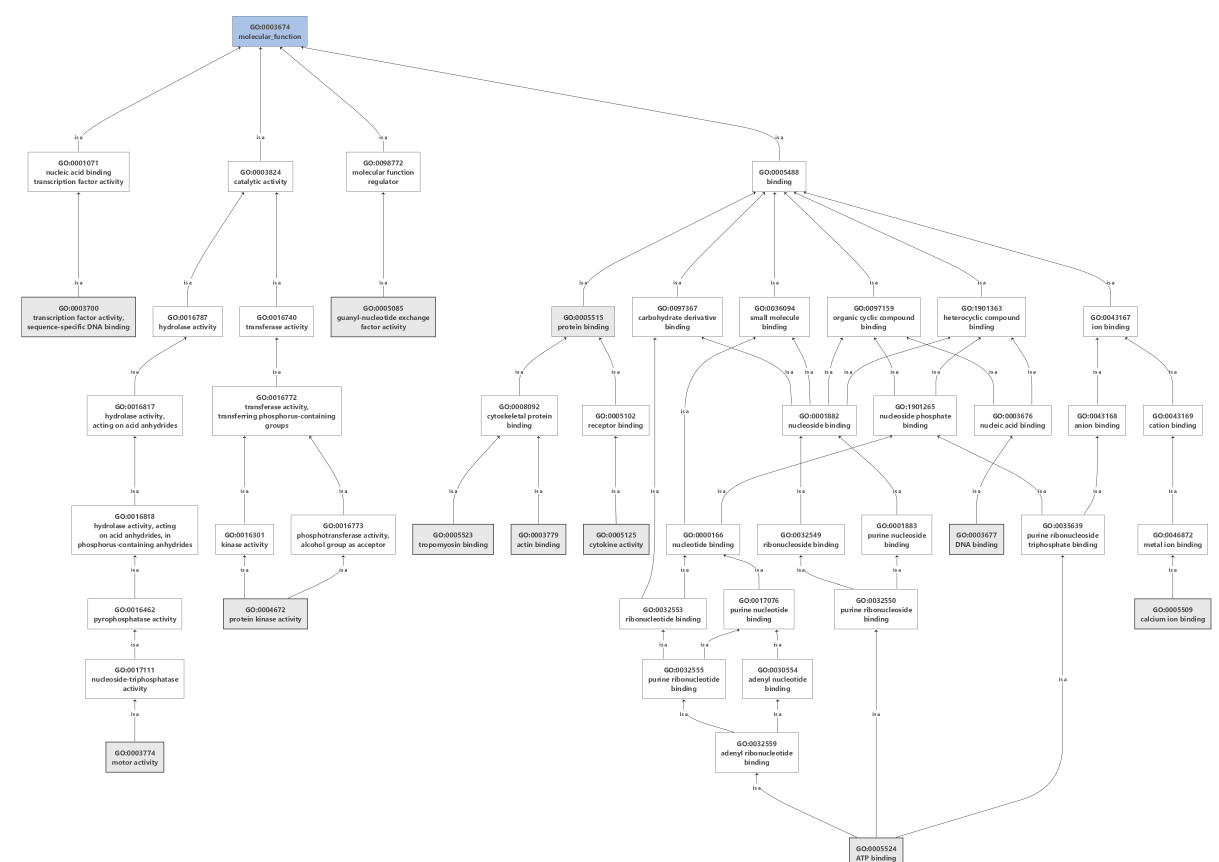
Figure 3. Gene ontology of molecular function for growth traits in